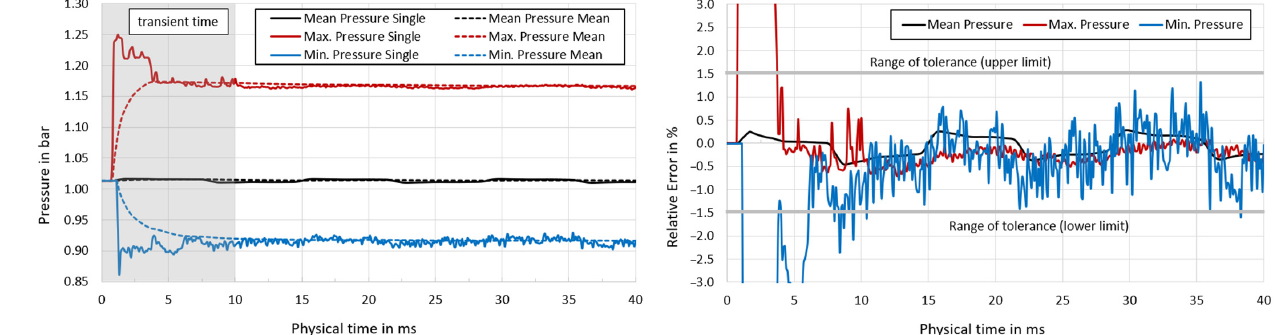
Figure 7. Minimum, maximum, and mean pressure of ‘Region of Interest’ and the corresponding moving average ( left ). Relative error of single values for pressure and moving average ( right ).